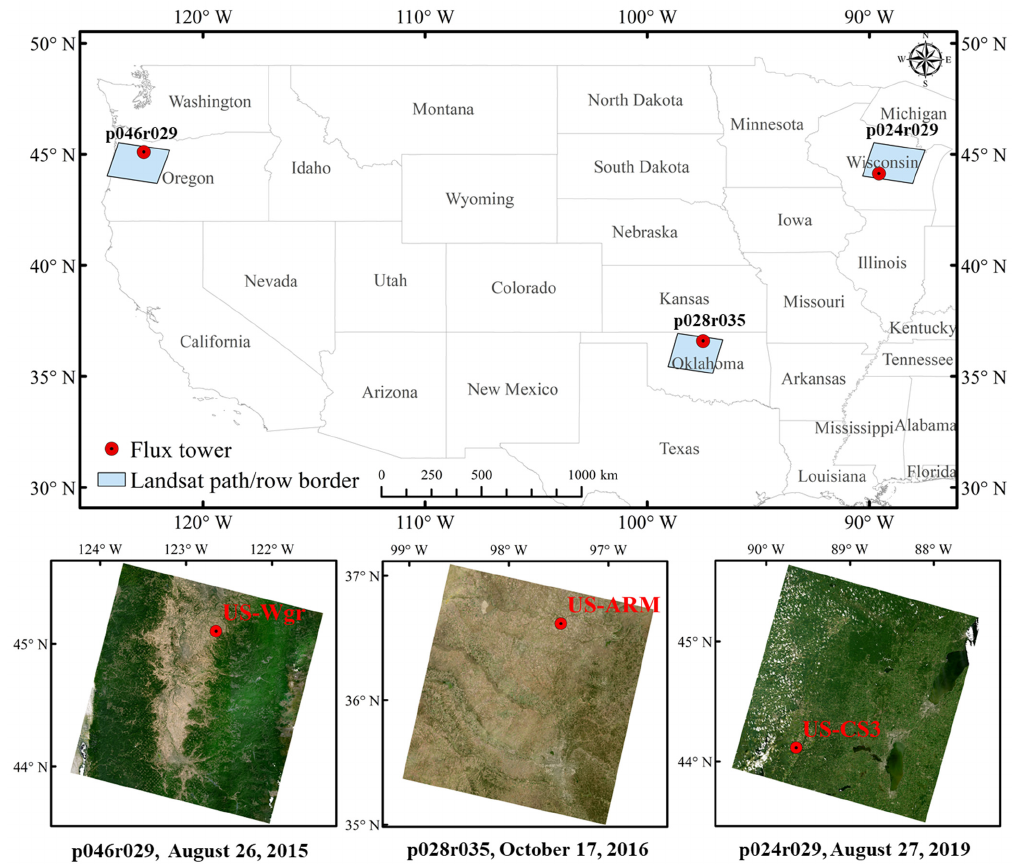
Figure 1. The locations of three study areas ( top ) and corresponding Landsat 8 OLI true-color surface reflectance images ( bottom ), where the pxxxryyy indicates the path and row numbers.